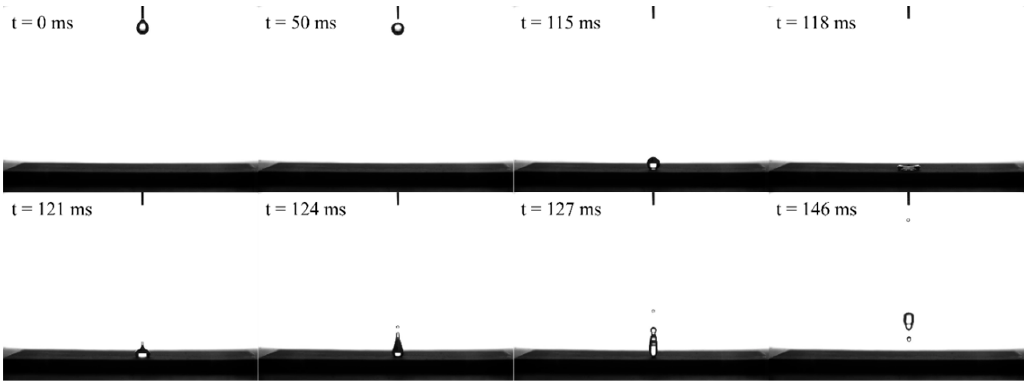
Figure 5. Selected frames from the high-speed video acquired from a 10 µL droplet (13 mm diameter) free-falling from a 300-mm height on PT5x3.